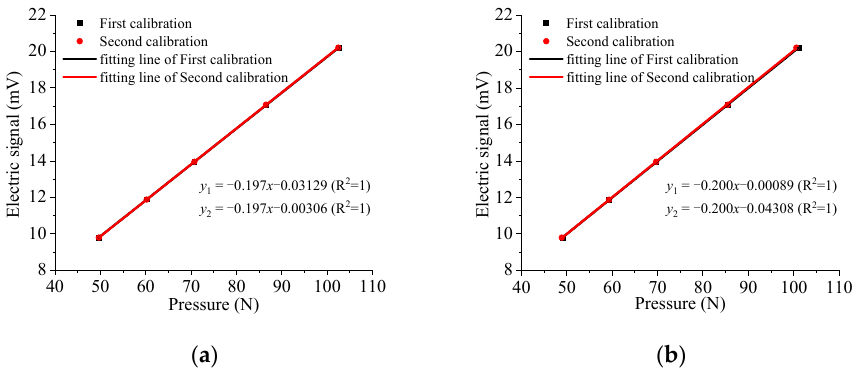
Figure 5. Temperature calibration of the load cell at 20 °C and 4 °C: ( a ) Pressure calibration at 20 °C; ( b ) Pressure calibration at 4 °C.